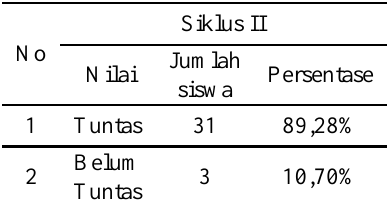
Tabel 3. Perbandingan Distribusi Frekuensi Nilai Mata Pelajaran IPA Pra Siklus dan Siklus I